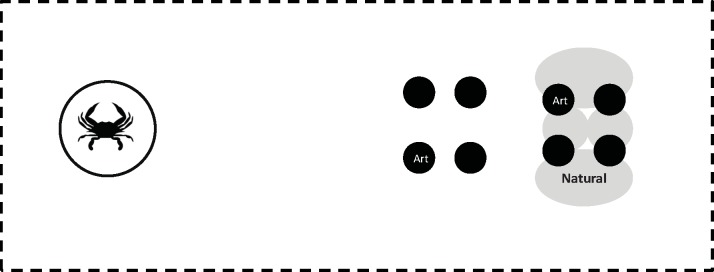
Enclosure cage.Diagram of the enclosure cage design (not to scale), showing the enclosure cage, the predator cage, the four artificial oyster clusters (Black; Art) outside and inside the natural clusters that form the refuge (Grey; Natural). Not shown is the additional predator cage located outside the enclosure, which is at the end opposite the predator cage within the enclosure. Note that only 1 of the four artificial clusters within and outside the refuge is labeled, as is only 1 of the four natural clusters forming the refuge.